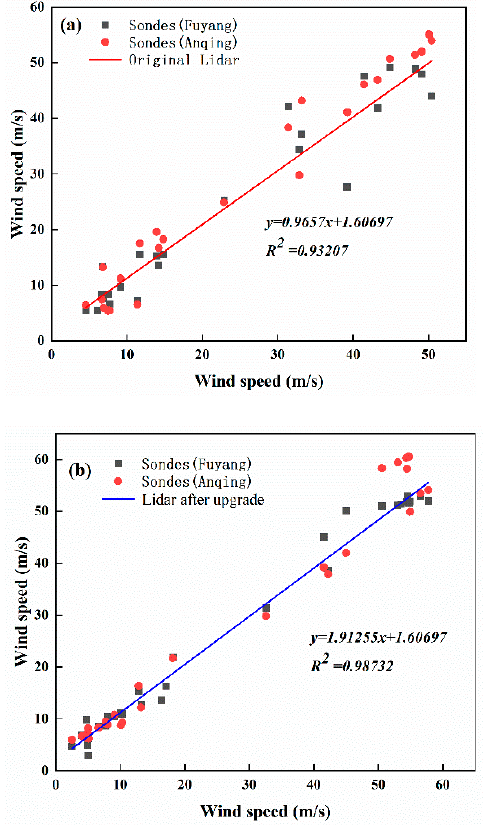
Figure 19. Correlation coefficient R 2 of Lidar and radiosondes detection data. ( a ) Original ( b ) Up- graded.